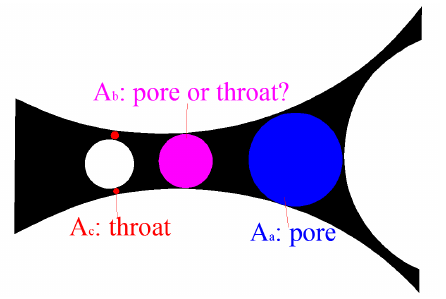
Figure 18. Example of dilemma of distinguishing between pore and